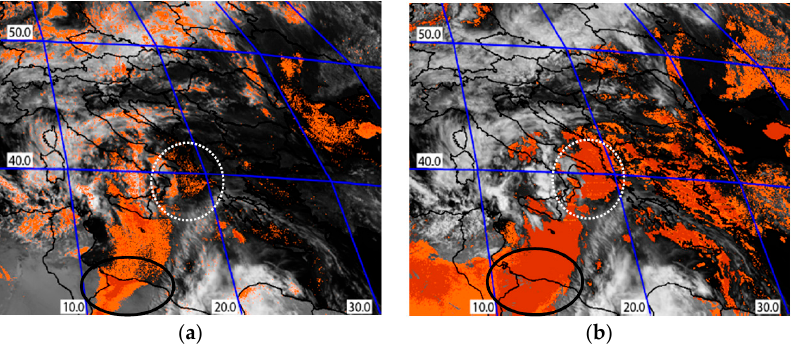
Figure 2. SEVIRI data of 19 May 2008 at 09:15 UTC (in satellite projection) with the visible channel reported in background; ( a ) standard RST DUST algorithm, with ⊗ Δ TIR ( x,y,t ) < − 2 (orange pixels) and ⊗ Δ TIR ( x,y,t ) < − 3 (brown pixels); ( b ) e RST DUST with ⊗ VIS ( x,y,t ) > 0 ( L ), 1 ( S ) AND ⊗ TIR ( x,y,t ) > − 2 AND ⊗ Δ TIR ( x,y,t ) < − 1 (orange pixels) and ⊗ VIS ( x,y,t ) > 0 ( L ), 1 ( S ) AND ⊗ TIR ( x,y,t ) > − 2 AND ⊗ Δ TIR ( x,y,t ) < 0 (brown pixels). The white circle and black ellipse indicate two different regions (i.e., Southern Italy and Libya) where, according to e RST DUST , the dust phenomenon was particularly intense.